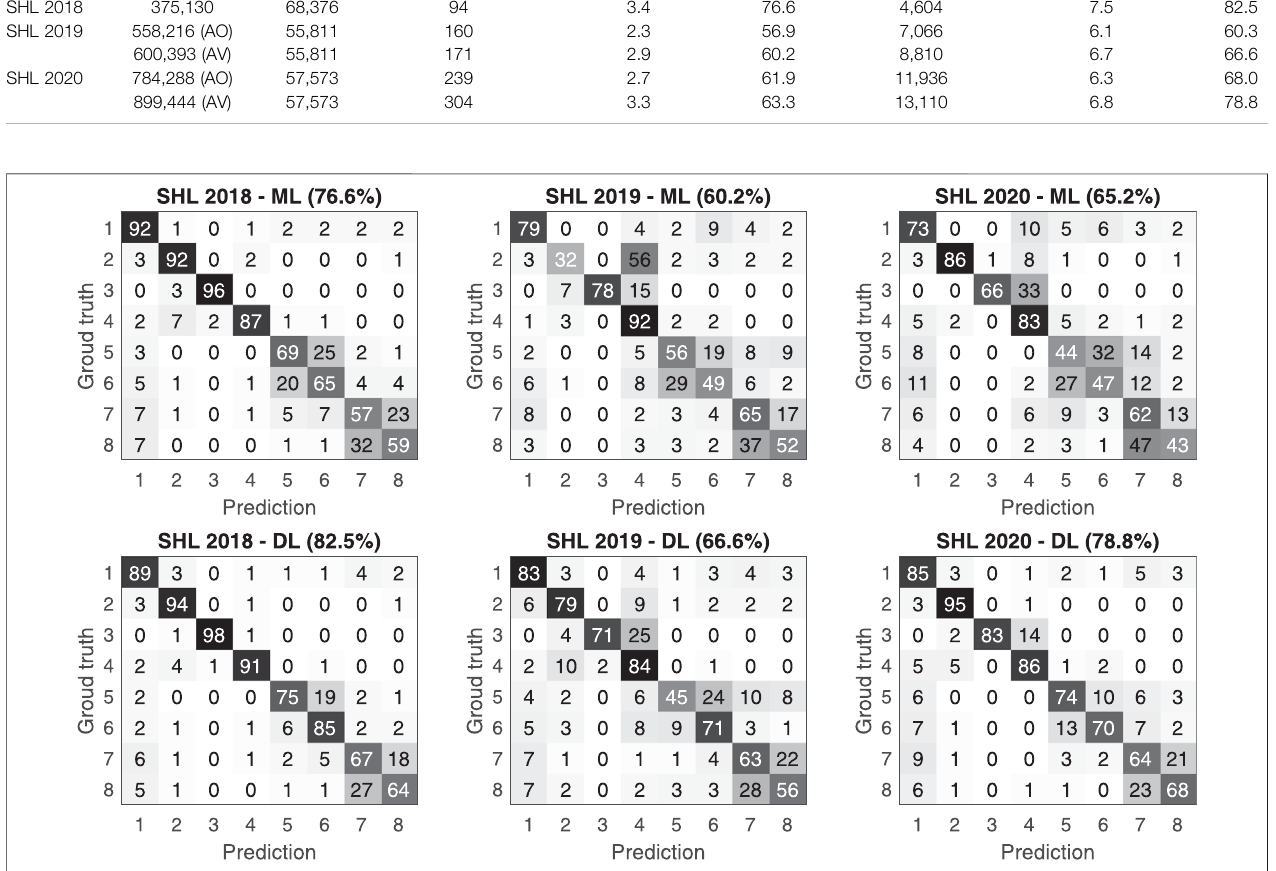
FIGURE 16 | Confusion matrices of the ML and DL baseline systems for SHL 2018 – 2020 with a 5-s decision window. The eight class activities are: 1 — Still; 2 — Walk; 3 — Run; 4 — Bike; 5 — Car; 6 — Bus; 7 — Train; 8 — Subway.